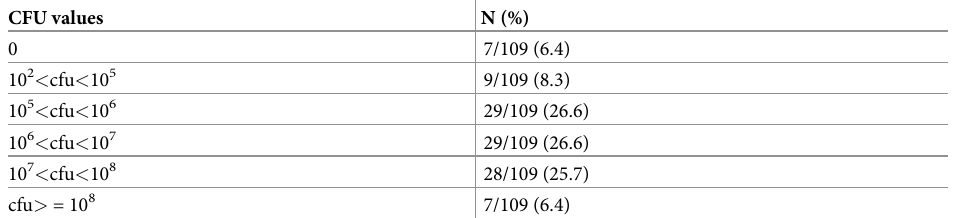
Table 2. CFU values in duodenal aspirates of stunted children (N = 109). SIBO is defined as greater than 10 5 CFU/ ml of upper intestinal aspirate as assessed by both anaerobic and aerobic cultures [16].